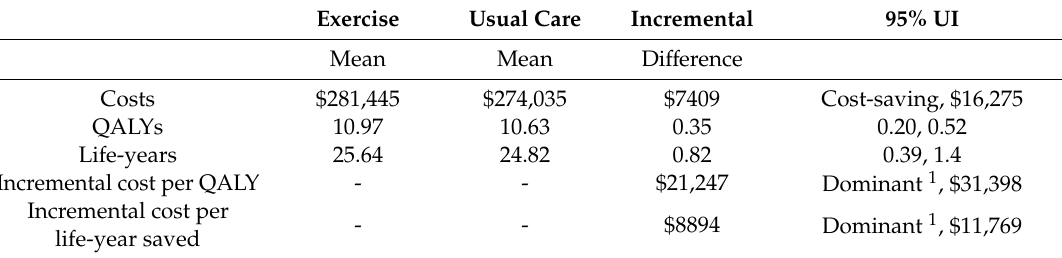
Table 2. Main results for costs $AU, quality-adjusted life years and life-years.